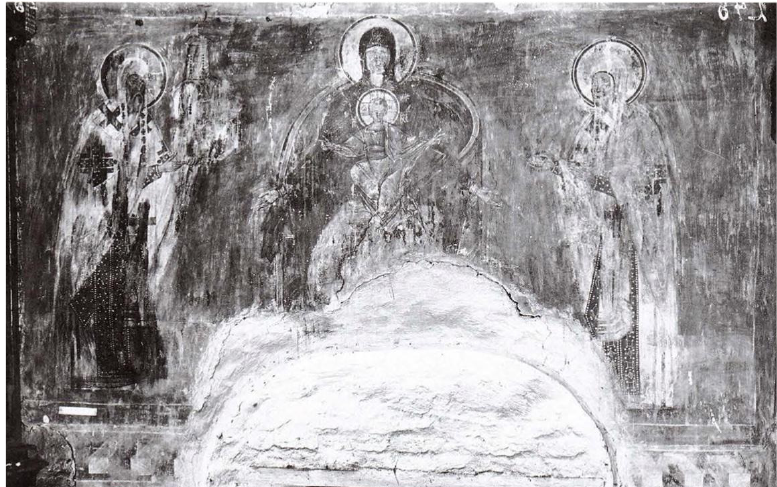
Figure 7. Archbishops Moisei (1325–1330, 1352–1359) and Alexei (1359–1388) of Novgorod appear before the Mother of God and Christ child enthroned. The archbishops are depicted with halos, an indication of sainthood. Fresco in the Church of the Assumption in Volotovo, Novgorodian Land. Late 14th century. Photograph by L.A. Matsulevich, 1910 (Matsulevich 1910), Novgorod Society of Antiquity Lovers.